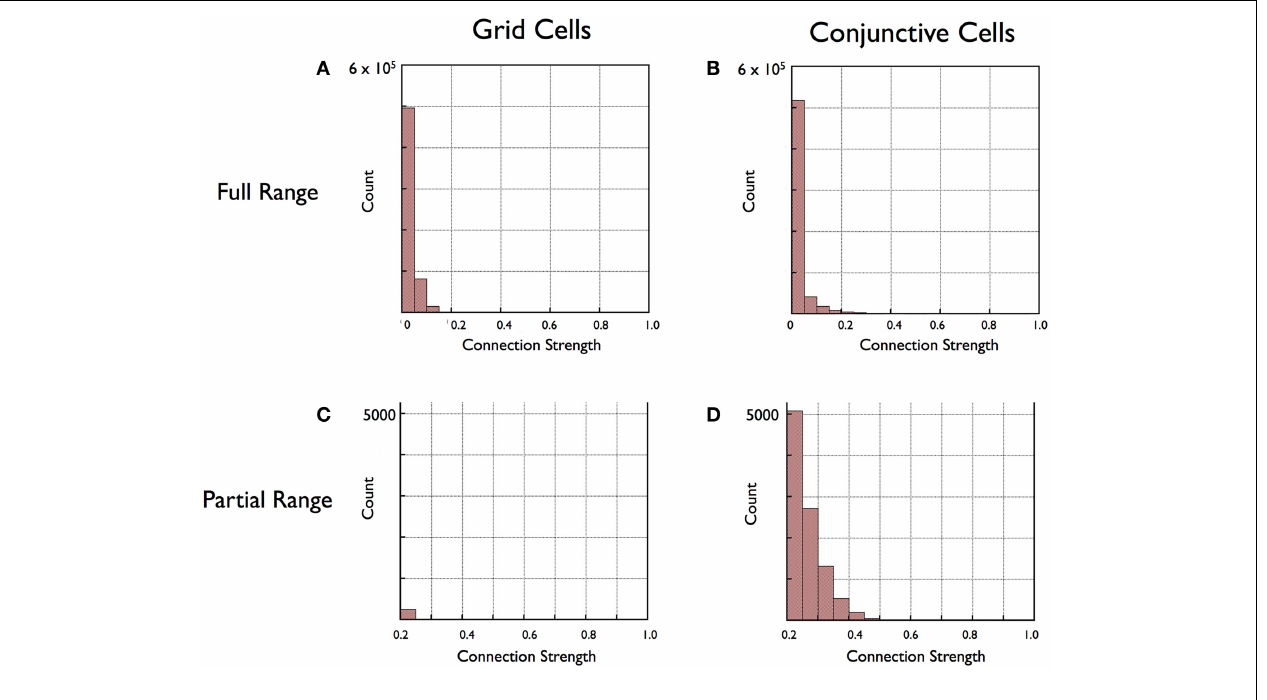
FIGURE 8 | Histograms of results for connection strengths (co-activity indices) between all cell pairs in a rigid grid cell module (A,C) and conjunctive cell module (B,D). (A,B) show that for both Grid Cells and Conjunctive cells that great majority of scores are low, roughly 80% of the